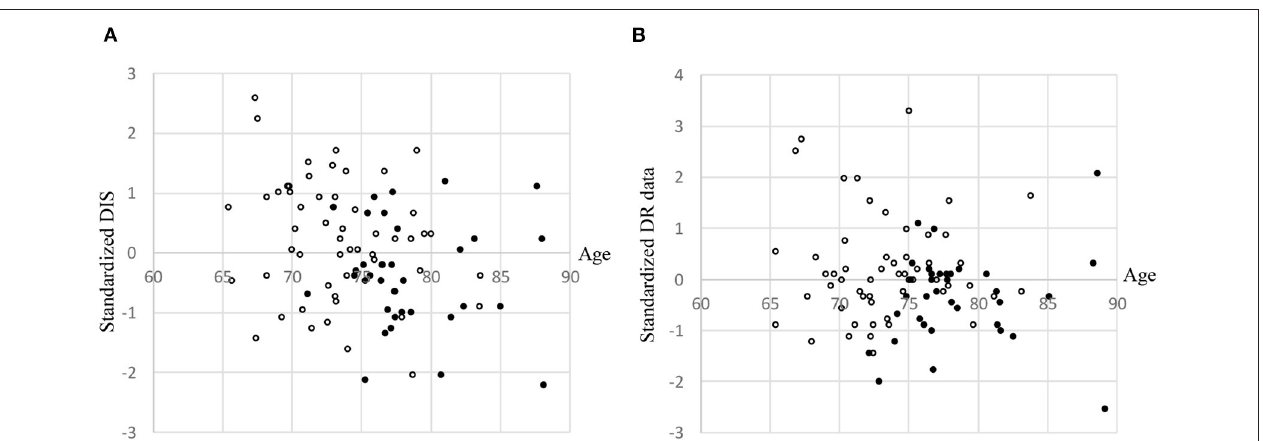
FIGURE 3 | Scatter plots stratified according to leukoaraiosis (LA) grade and brain atrophy (BA). (A) Driving Instructor’s Score (DIS). (B) Driving recorder (DR) data. •: LA ≥ 2 and BA ≥ 0.2176. ◦ : All others. DIS and DR data were standardized. In order to avoid overlapping dots, small random values ( M = 0, SD = 0.5) were added to each participant’s